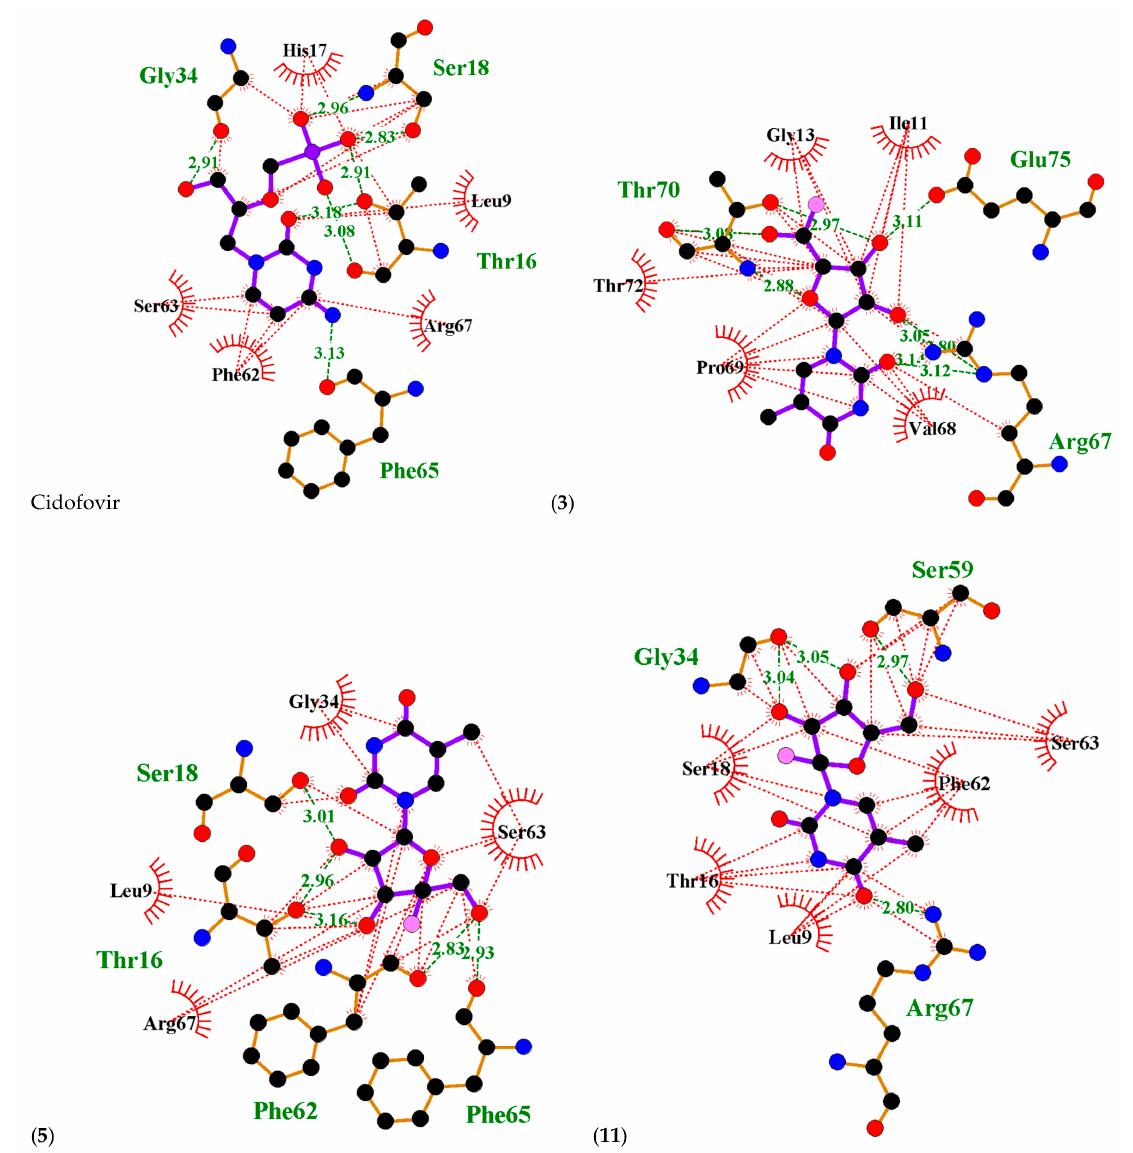
Figure 4. Ligplots showing the interacting residues of cidofovir and arabinofuranosyl-thymine-related structures ( 3 ), ( 5 ), and ( 11 ) with the cowpox OMCP protein. Purple lines, arabinofuranosyl-thymine-related structures ligand bonds; orange lines, non-ligand bonds; green dotted lines, hydrogen bonds labelled with distances in Å; red dotted lines, hydrophobic interactions; red circles, oxygen atoms; blue circles, nitrogen atoms; black circles, carbon atoms; pink circle, fluorine atoms; radial lines, non-ligand residues involved in hydrophobic contact(s).